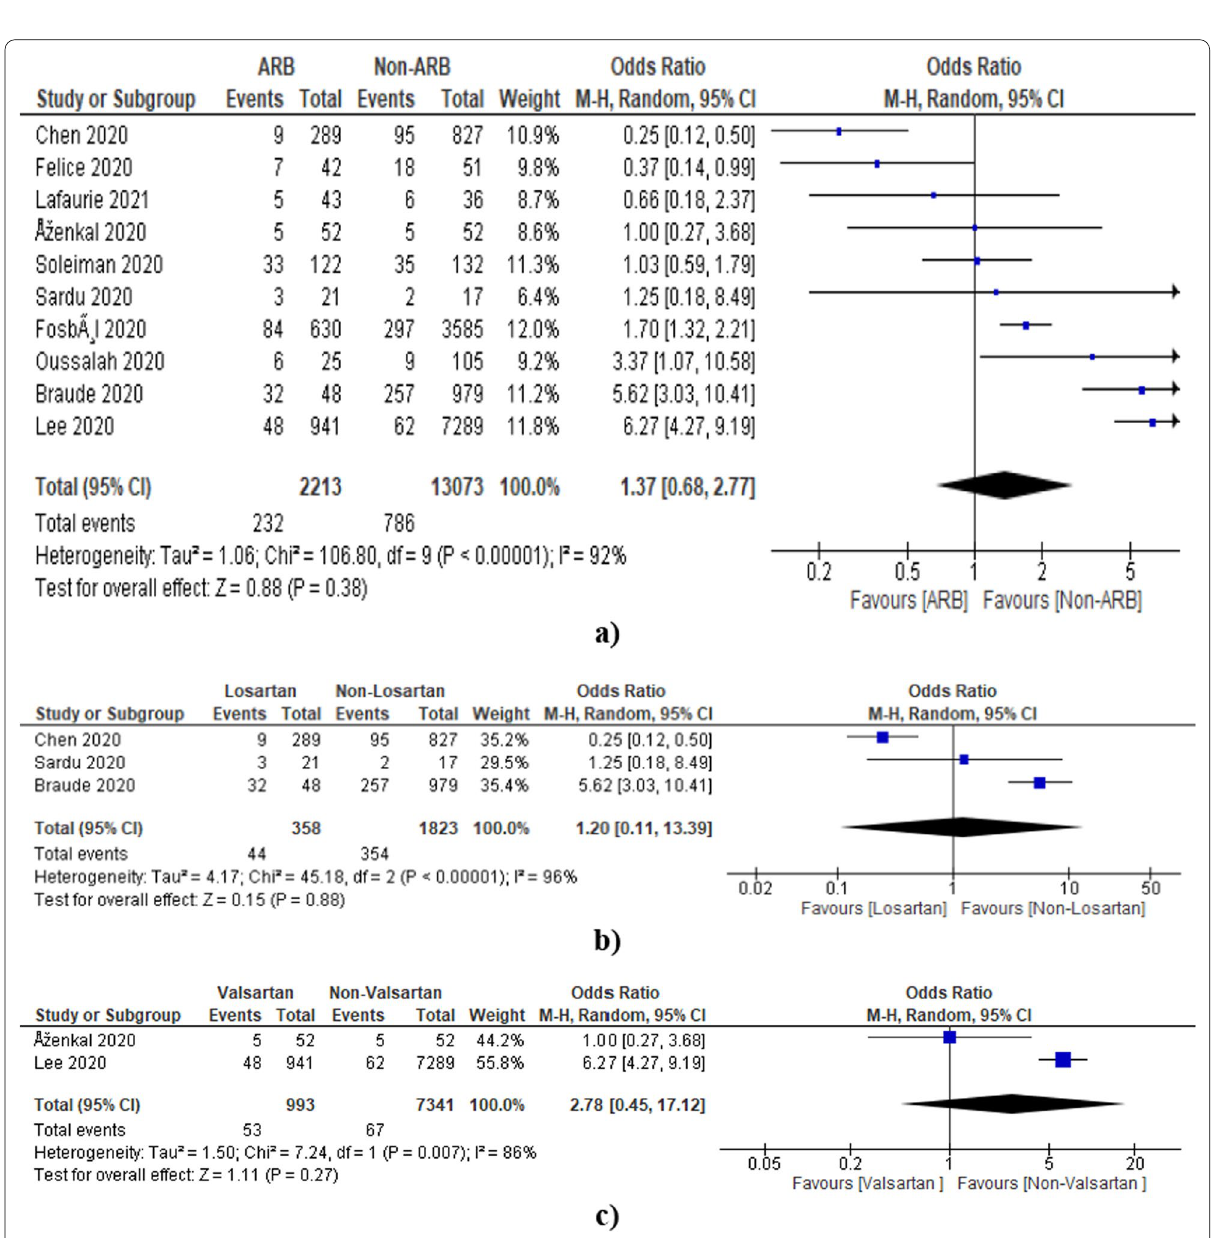
Fig. 6 Forest plot showing overall estimate in terms of odds ratio using random effect model a ARBs b Losartan c